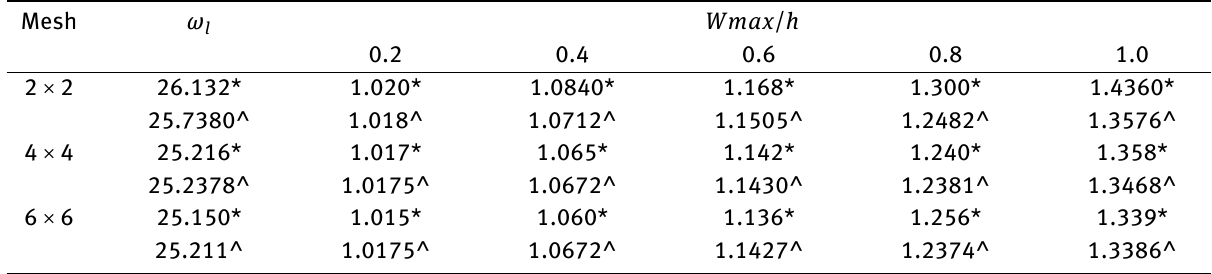
Table 4: Validation study of dimensionless mean nonlinear fundamental frequency of piezo laminated layers [P/0 ∘ /90 ∘ /90 ∘ /0 ∘ ] simply supported (S2) plate.